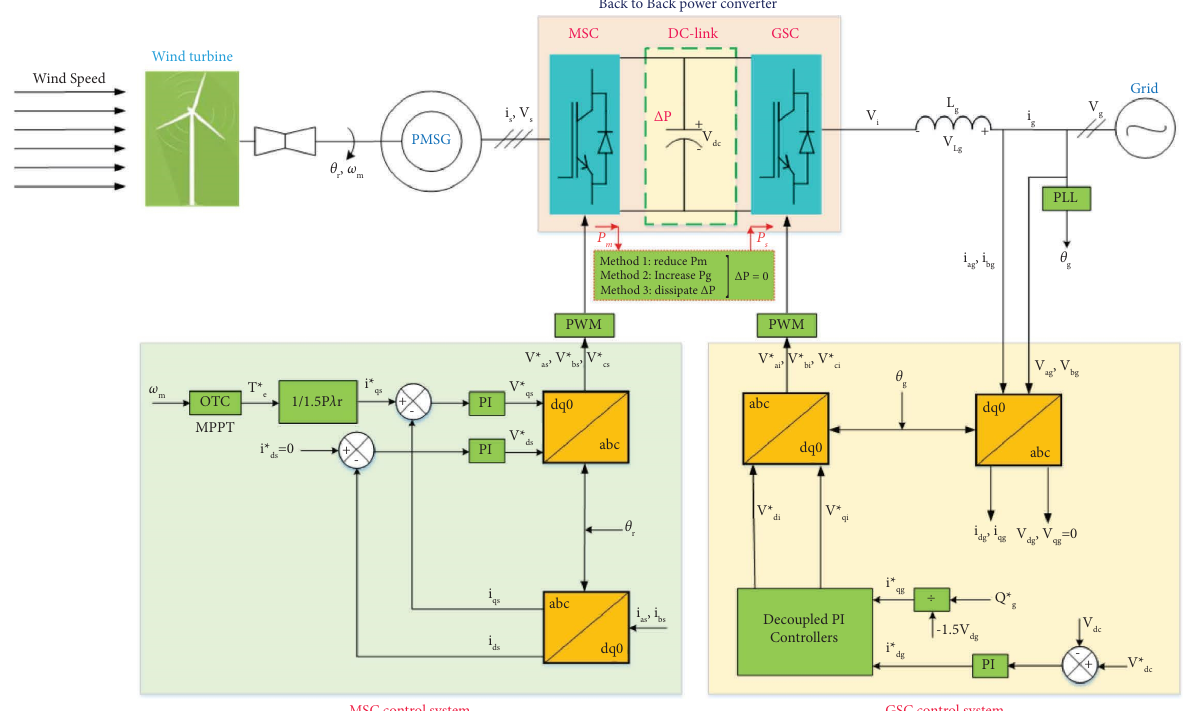
Figure 2: PMSWG connected to the grid via BTBCs with their control